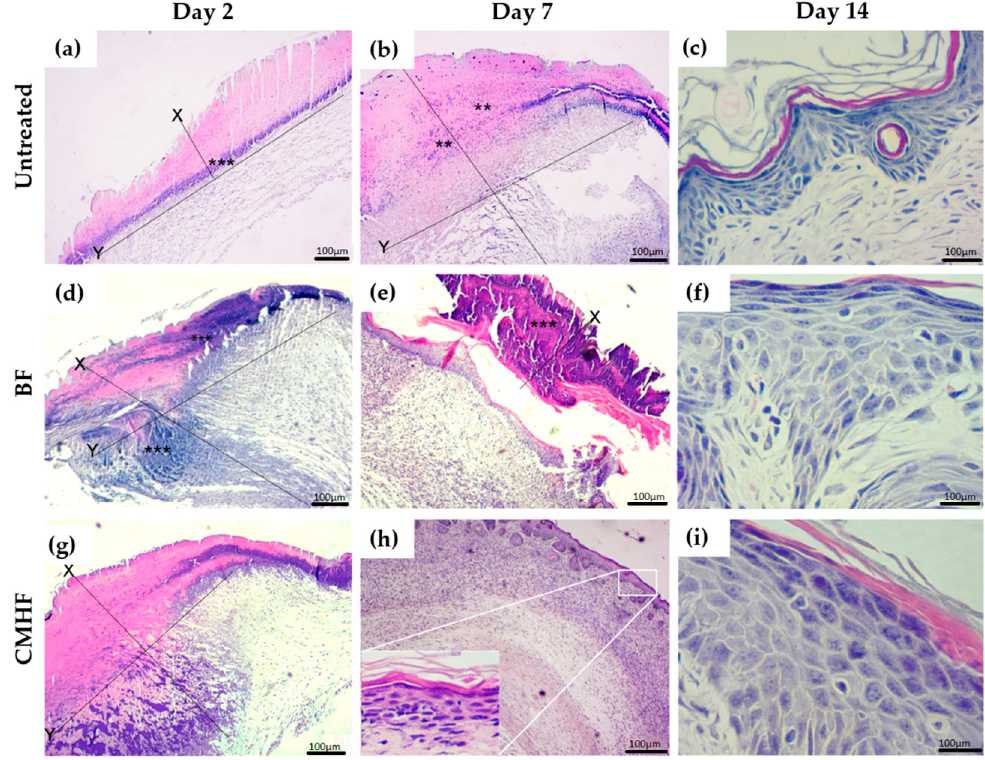
Figure 8. Hematoxylin-eosin (H&E) staining photomicrographs of biopsies of the untreated, BF and CMHF groups assessed at ( a , d , g ) day 2, ( b , e , h ) day 7, and ( c , f , i ) day 14. The x axis indicates lesion depth extending from the epidermis to the dermis and the y axis indicates lesion extension. Statistical difference demonstrated by ANOVA analysis with p < 0.05 followed by Bonferroni post-test ( n = 6).